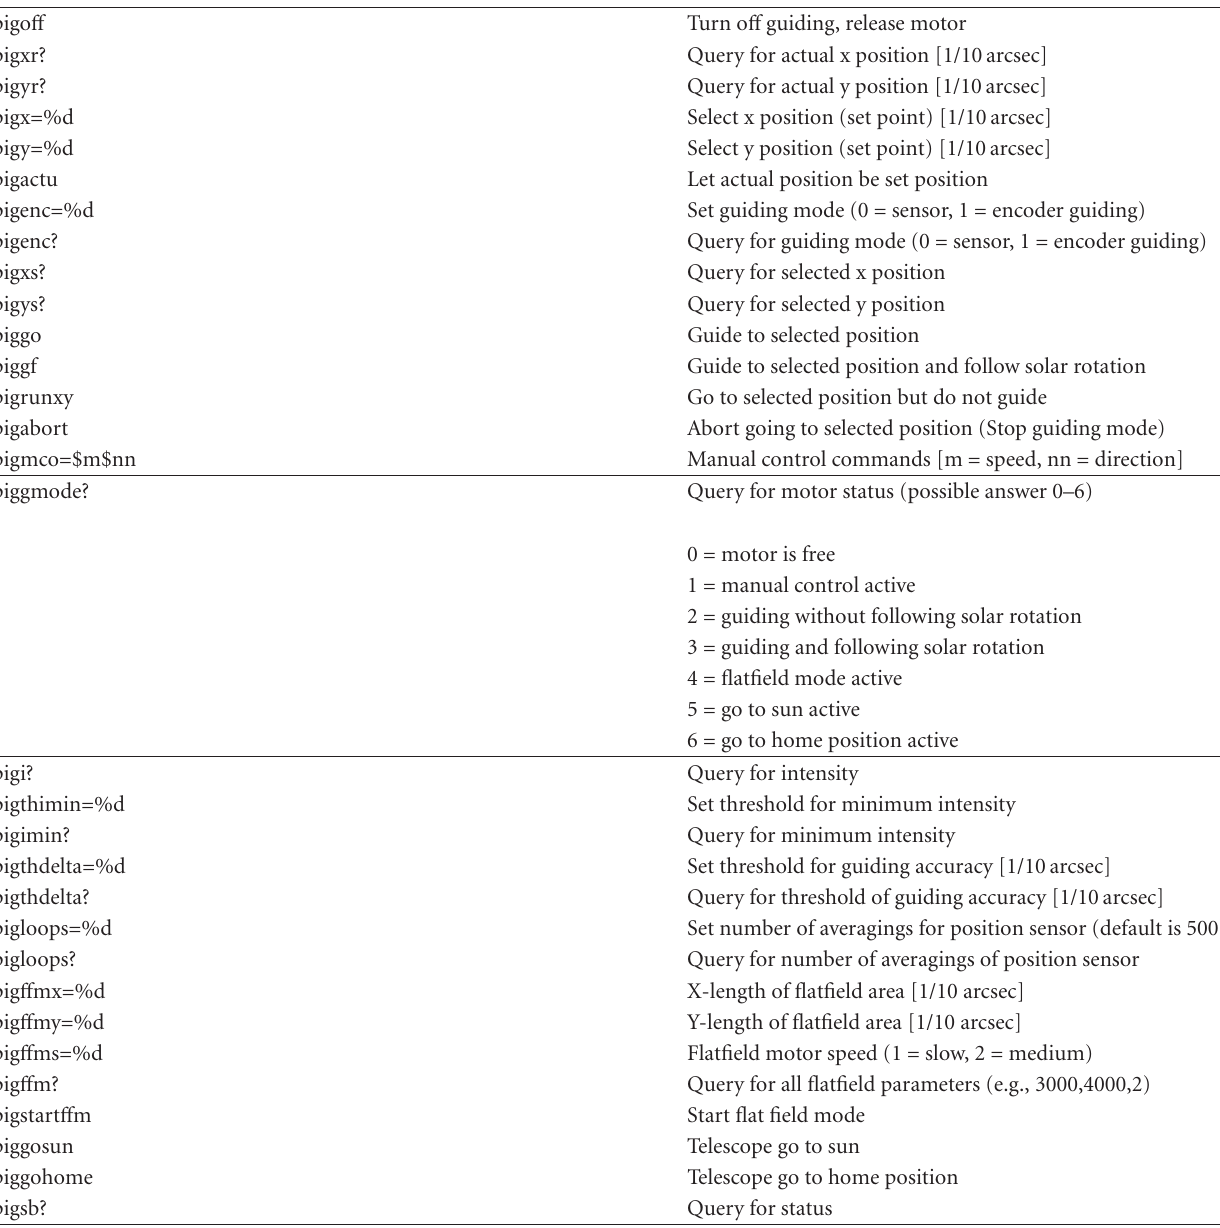
Table 1: Commands and functions of the telescope control